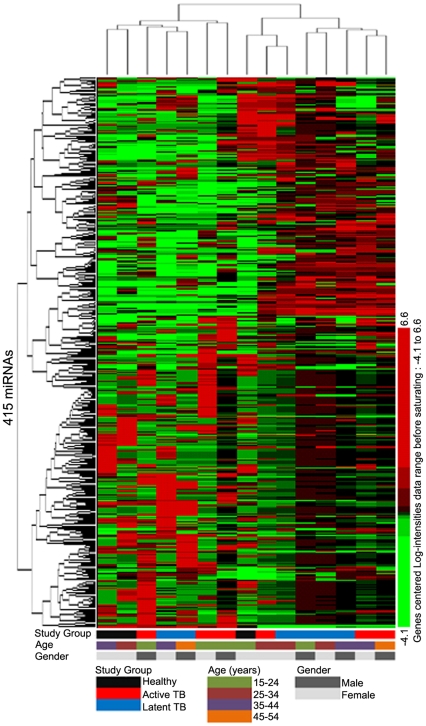
Unsupervised hierarchical clustering of the expression of 451 miRNAs.The tree was generated by unsupervised hierarchical clustering of PBMC miRNA profiles for patients with active TB, subjects with LTBI, and healthy controls. MiRNAs with 2-fold up- or down-expression compared with the median intensity across all samples and differential expression values greater than 10% of all samples were selected for unsupervised analysis (n = 415 miRNAs). Sample clusters can be compared with the clinical parameters displayed in blocks underneath each profile. A key is provided at the bottom of the figure. Subjects' clinical status is indicated as follows: patients with active TB are indicated by red rectangles; subjects with LTBI by blue rectangles; and healthy controls by black rectangles. Age is indicated as: subjects between 15–24 years old are indicated by olive green rectangles; subjects 25–34 years old by brown rectangles; subjects 35–44 years old by purple rectangles; and subjects 45–54 years old by khaki rectangles. Females are indicated by hoar rectangles and males by darkish rectangles.